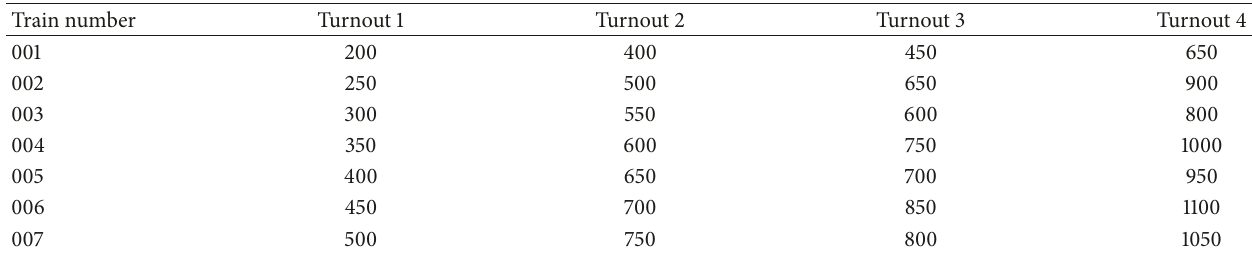
Table 2: The obtained timetable through FCFS algorithm in case of delay.